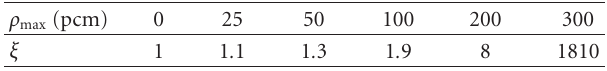
Table 2: Behavior of the fundamental eigenvalue ξ as a function of the reactivity